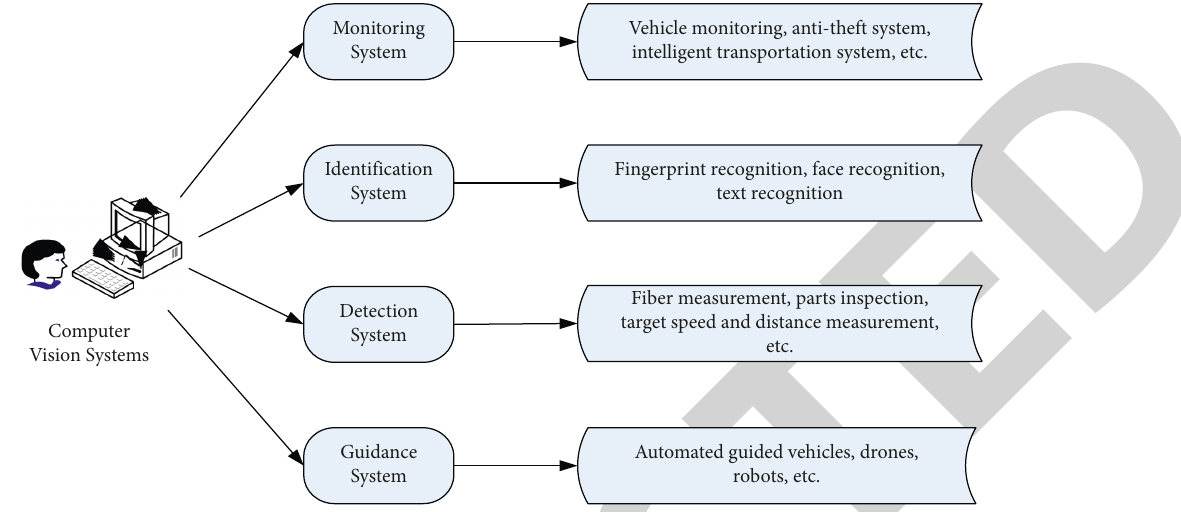
Figure 1: Classification of computer vision